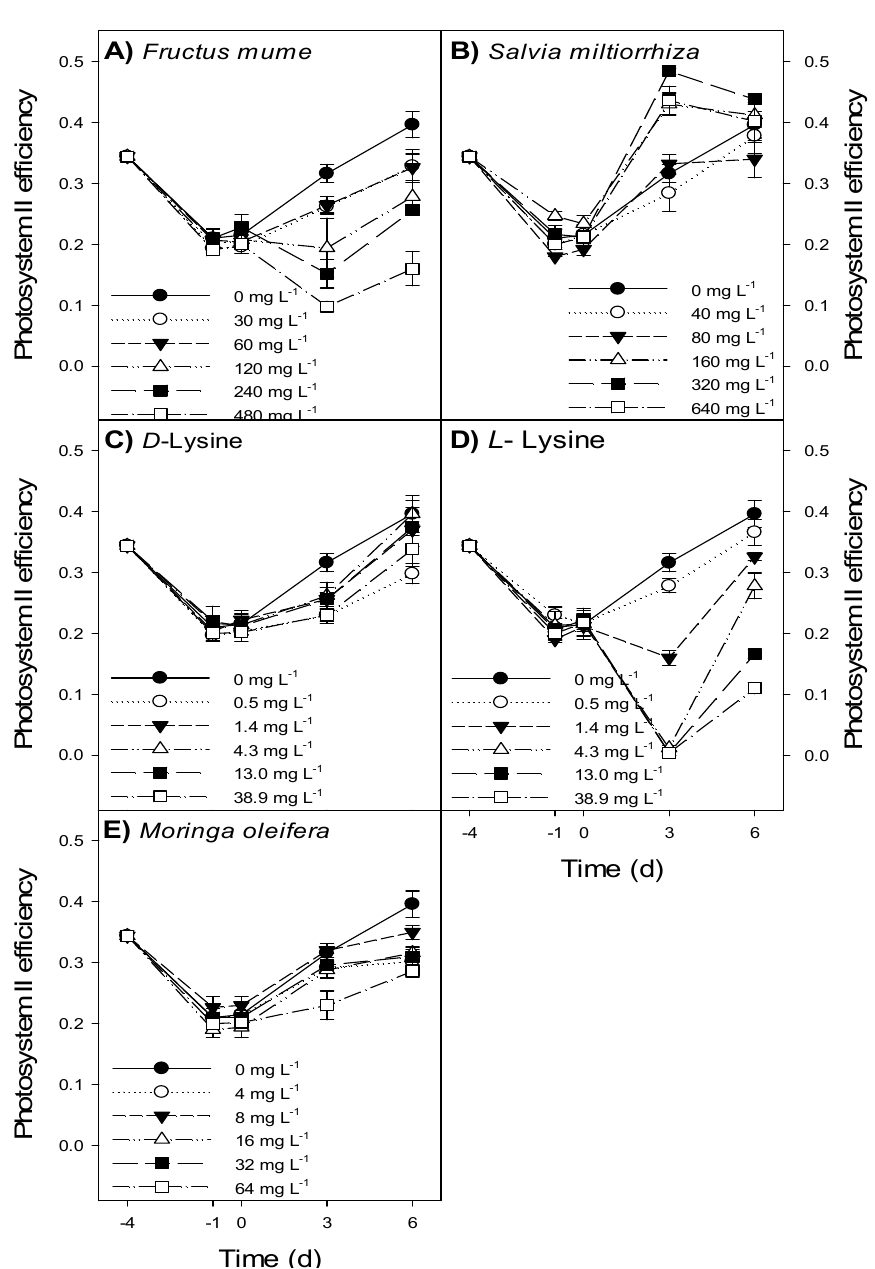
Figure 2. Course of the Photosystem II efficiencies in Microcystis aeruginosa populations grown for four days ( − 4 d to 0 d) in the absence and six days (0 d to 6 d) in the presence of filtered extracts from Fructus mume ( A ); Salvia miltiorrhiza ( B ); in presence of different concentrations D -lysine ( C ); L -lysine ( D ); and in Moringa oleifera seed extract ( E ). Error bars indicate one standard error ( n =